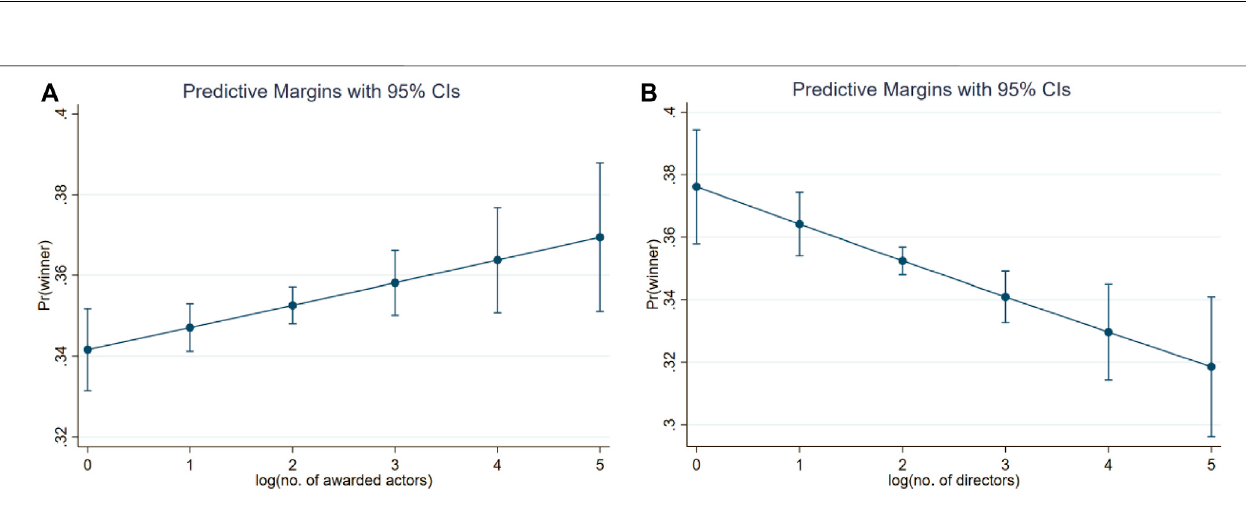
Frontiers in Physics |